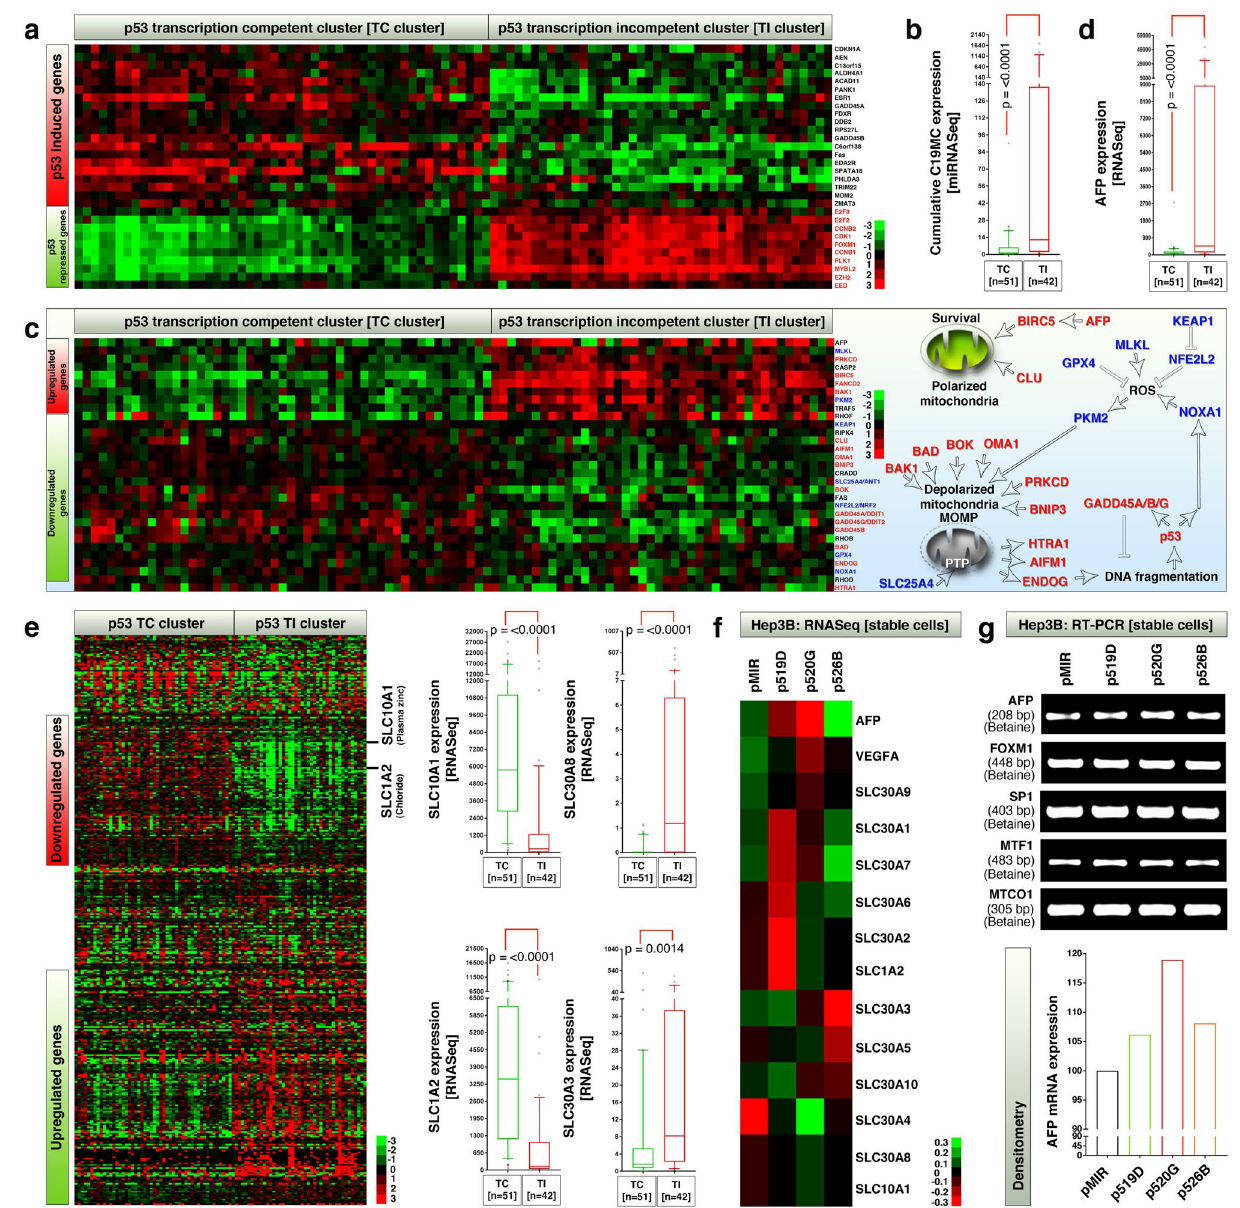
Figure 2. Overexpression of C19MC, AFP and zinc efflux pump RNAs are restricted to p53 transcription incompetent HCCs and miR-520G promotes AFP mRNA expression. ( a ) LIHC (HCC) classification of p53TC, p53TI tumors based on 10 p53-repressed genes and 20 p53-induced genes. Two large clusters that show clear differences were chosen. ( b ) HCCs showing overexpression of C19MC miRNAs in p53-TI cluster. ( c ) Heatmap of 31 genes showing differences between p53TC and p53TI clusters out of 200 cell death regulatory genes examined. ( d ) Overexpression of AFP in p53TI cluster ( e ) 324 SLC family gene heatmap showing a massive panel of SLC family members differ between p53TC and p53TI clusters. Major zinc-related SLCs are shown in box-whisker plots. ( f ) RNA-seq heatmap showing that, AFP, and zinc transporters/efflux pumps are promoted by C19MC miRNAs in stably transfected Hep3B cells. ( g ) RT-PCR showing C19MC miRNA regulation of AFP and AFP-transcription factors in Hep3B miRNA overexpressed Hep3B stable cells. Relative AFP mRNA expression quantified by densitometry is shown as bar graph in bottom